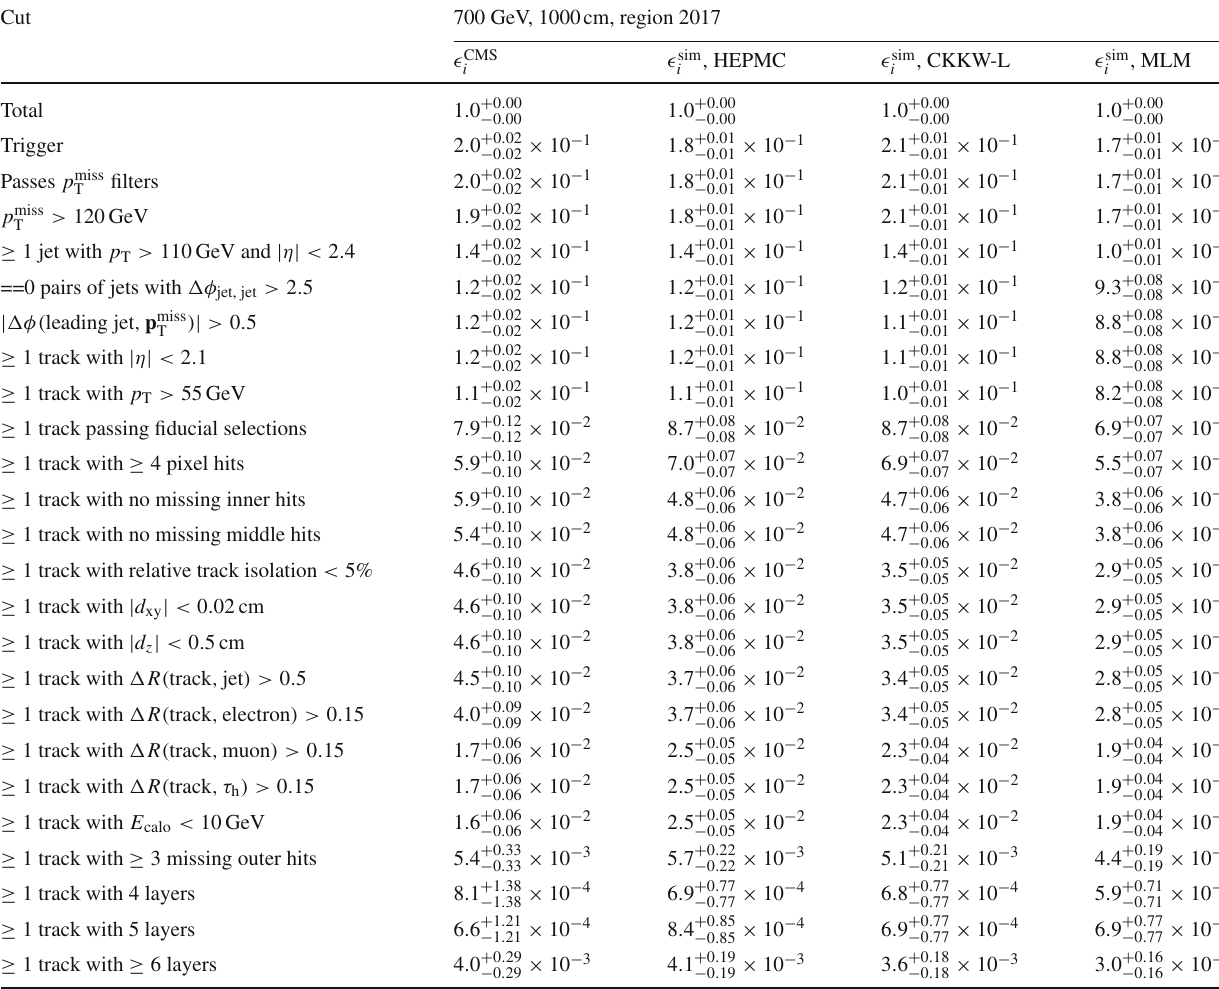
Table 7 Comparison of jet matching/merging approaches in cutflows for 700 GeV, 1000cm winos, region 2017